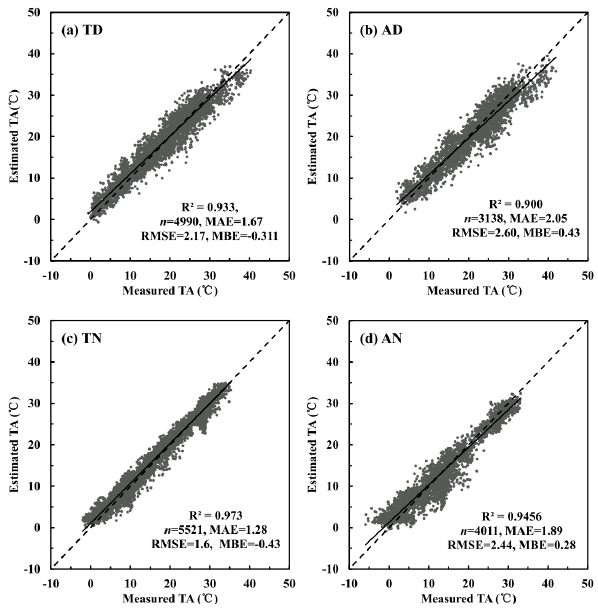
Figure 5. Scatter plots of measured TA from meteorological stations versus satellite-estimated TA based on stepwise linear regression at the four MODIS overpass times during 2012–2013: ( a ) Terra daytime (TD); ( b ) Aqua daytime (AD); ( c ) Terra nighttime (TN); and ( d ) Aqua nighttime (AN).